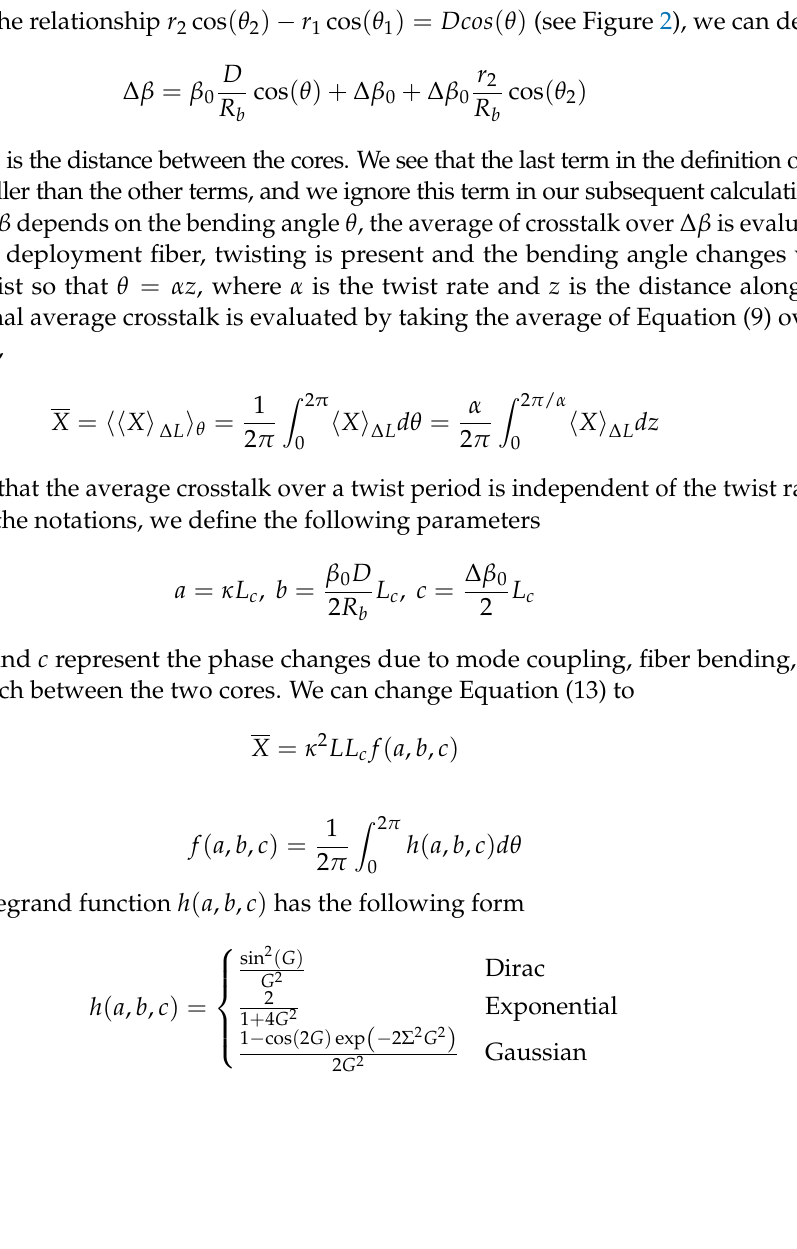
Figure 2. Schematics of a two-core fiber under a bend with a radius R b and the local coordinates used in the equivalent index model.